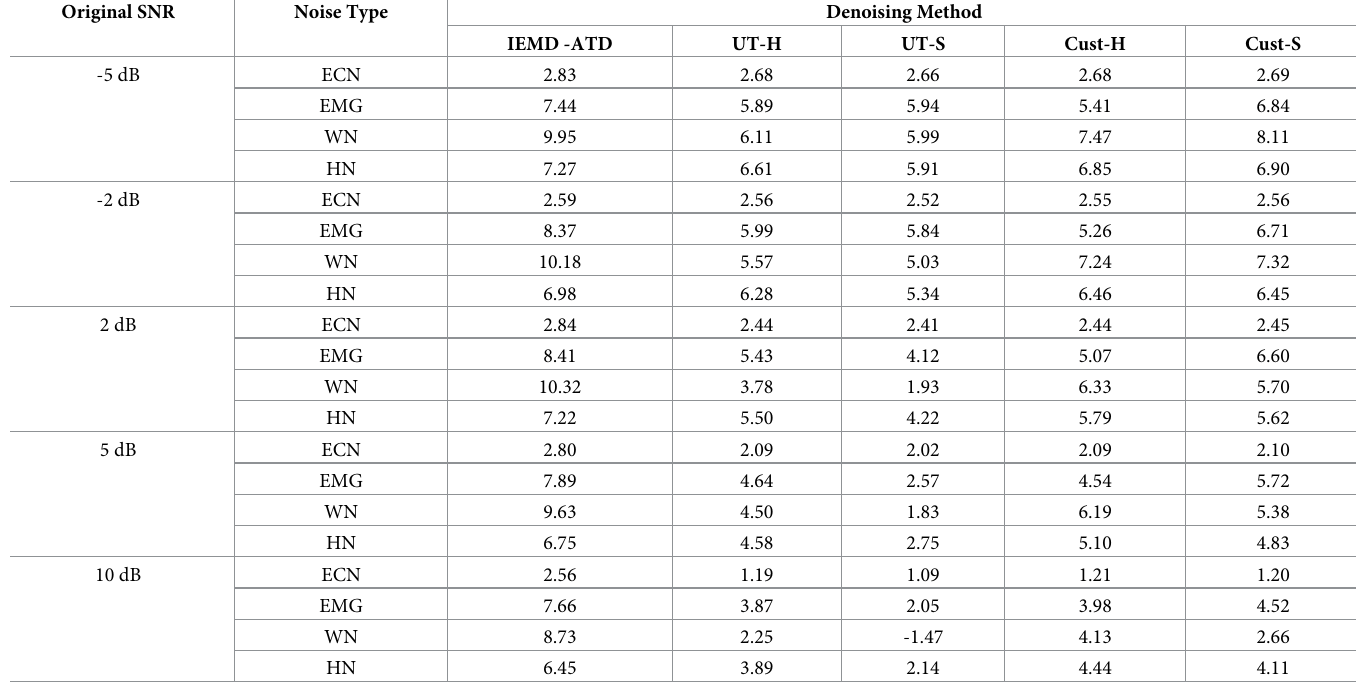
Table 6. Average SNR improvement of 6 synthetic ECGs (Syn00-Syn05). Original